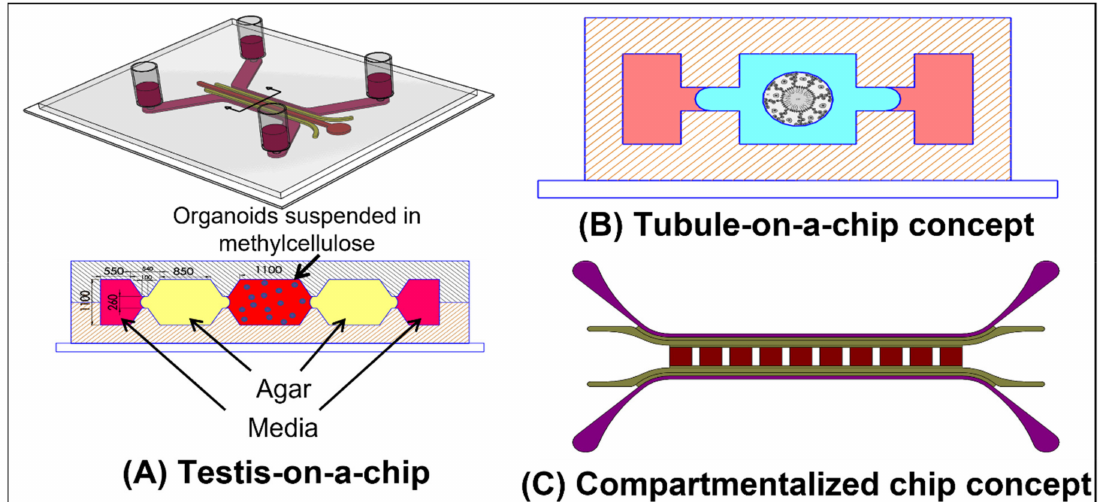
Figure 8. Testis-on-a-chip concepts from our group: ( A ) Our testis-on-a-chip design. The chip is made out of PDMS. Disassociated testicular cells are suspended in methylcellulose gel and seeded into the center channel. The next channels (colored in yellow) contain a relatively stiff agar gel, to retain the softer methylcellulose gel. The outermost channels are media channels, for a constant supply of nutrition and clearing of metabolic waste. Shorter capillary barrier-like channels, prevent the spillover of a gel to a neighboring channel during filling [103]. Reproduced with permission from Biofabrication; IOP Publishing, 2022. ( B ) A conceptual model of a tubular model within a gel (blue) flanked by media channels. Image of the tubule cross-section in the center of the model is reproduced with permission from the Journal of Membrane Biology; published by Springer Nature, 2010. ( C ) A conceptual model of separate culture chambers fluidically-connected on the same chip. This would allow co-culture of various organoids and the formation of consistently sized